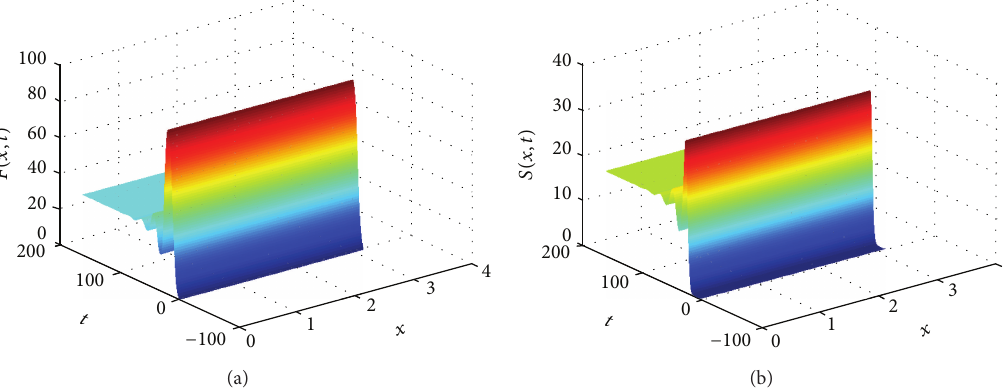
Figure 2: Plateau pika coexistence steady state 𝑤 ∗ with initial conditions 𝐹(𝑥,0) = 𝐹 0 (𝑥) = 1 , 𝑆(𝑥,0) = 𝑆 0 (𝑥) = 0.5